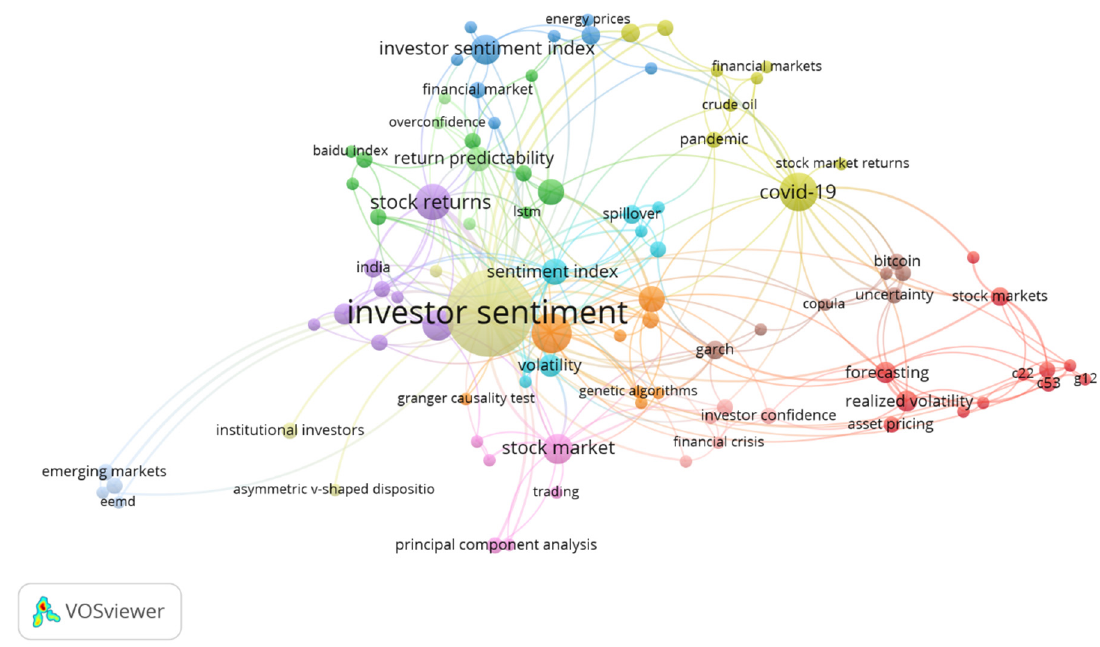
Figure 9. Most used terms used in titles.